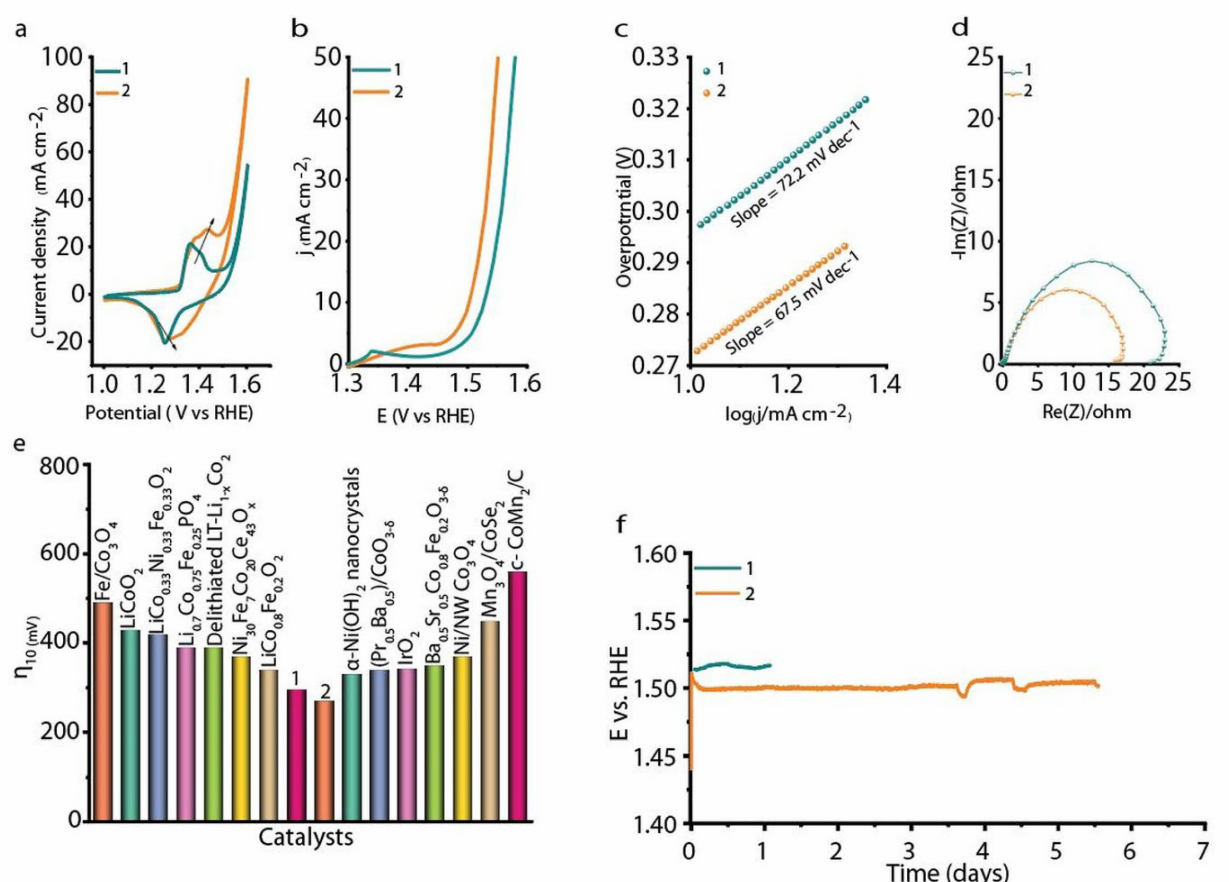
Figure 3. Comparison of electrochemical performances between 1 and 2 . ( a ) CV curves of 1 and 2 in oxygen saturated 1M KOH, where redox peaks indicate the electrochemical oxygen intercala- tion/(de)intercalation. ( b ) LSV Polarization curve of cathodes. ( c ) Tafel plots of cathodes, ( d ) Stability profiles, ( e ) Nyquist plots of cathodes in 1.0 M KOH, ( f ) Overpotentials at a standard current density of 10 mA cm − 2